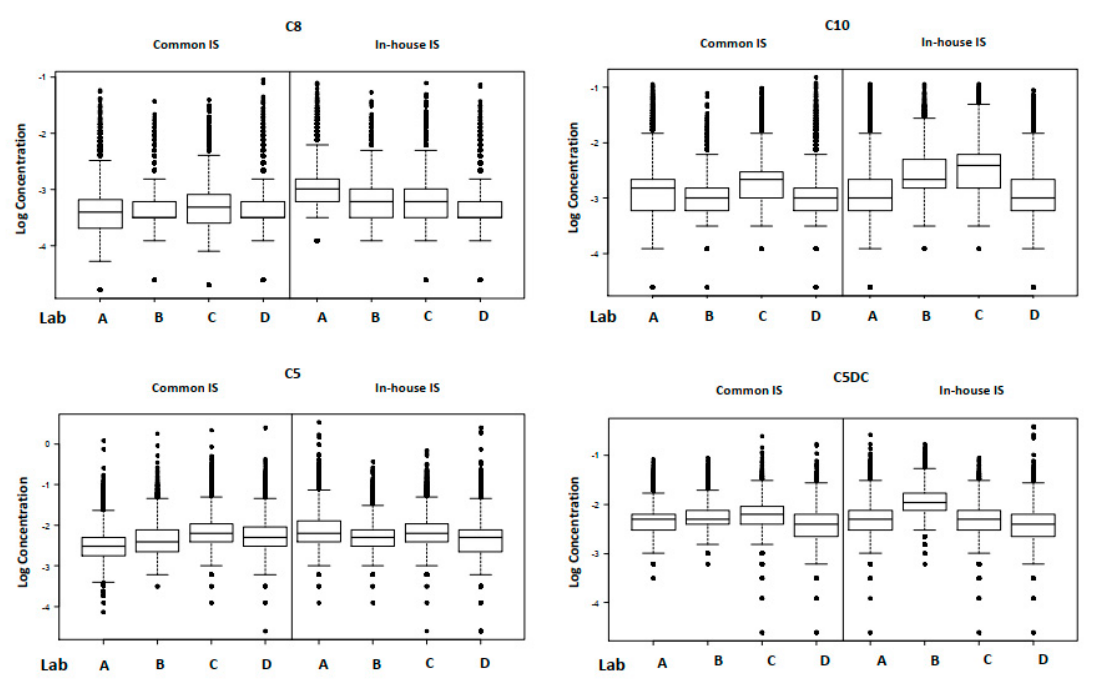
Figure 1. Box and whisker plots for the amino acids.